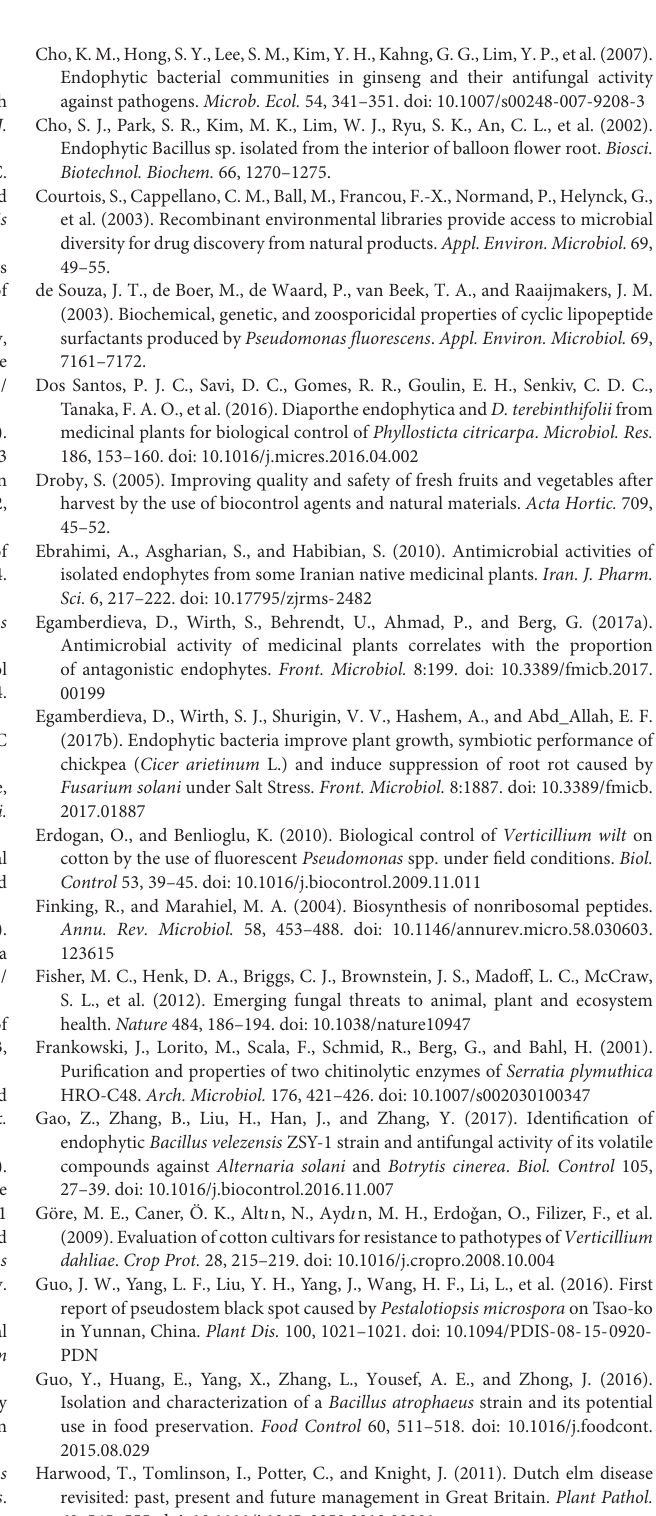
TABLE S6 | GC-MS identified components of the antibiosis crude extract of XEGI50 and V. dahliae mixture at pH3 (Volatile Compounds are listed in ascending order of Retention